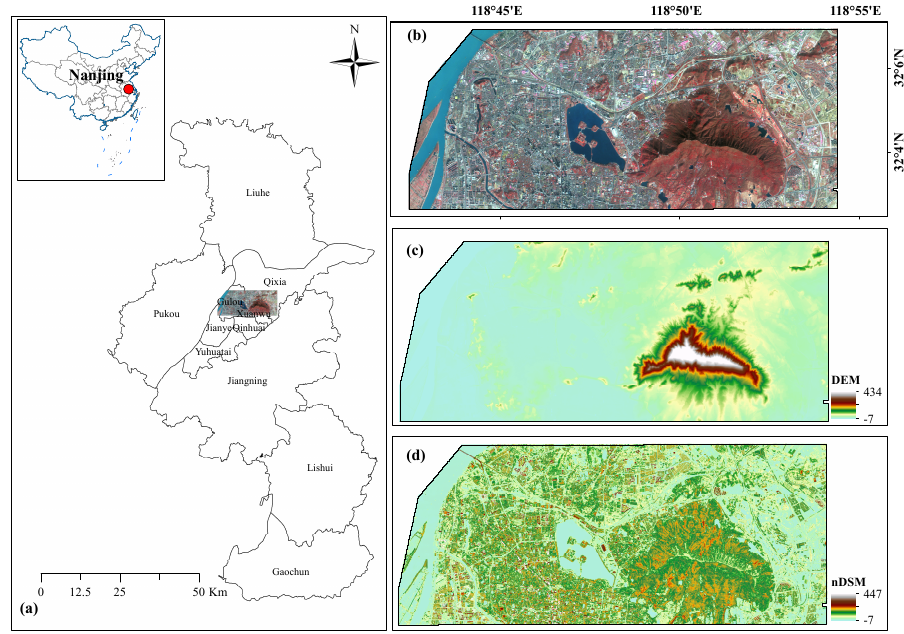
Figure 1. Maps of the study area are shown as follow: ( a ) Geographical position of the research area; ( b ) SPOT-5 multispectral false color composite image acquired on 1 January 2010; ( c ) Digital elevation model (DEM) and ( d ) Normalized digital surface model